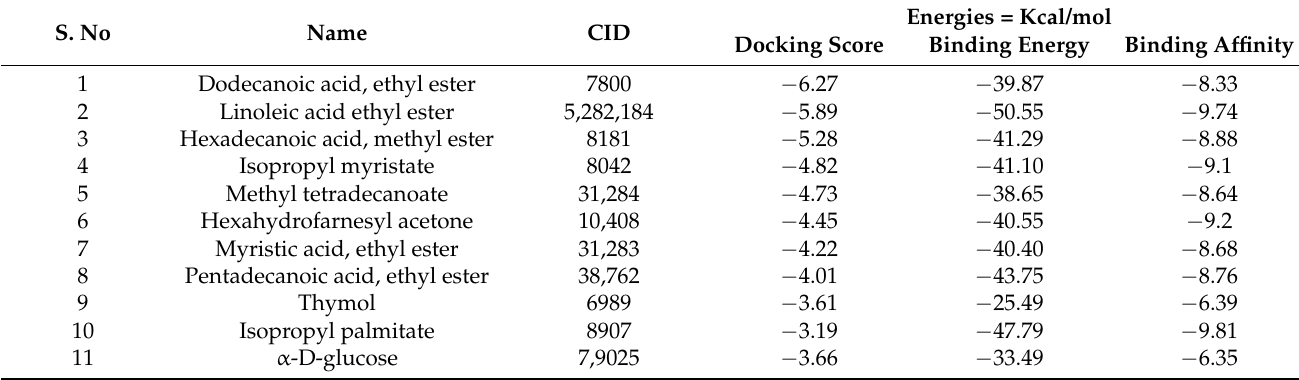
Table 4. Binding energy and binding affinity were calculated of 10 selected compounds having a reference substrate molecule ( α -D-glucose) with the α -glucosidase protein active site. S.